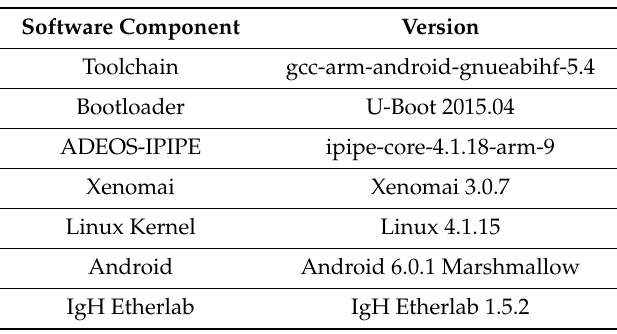
Table 1. Real-time environment for the